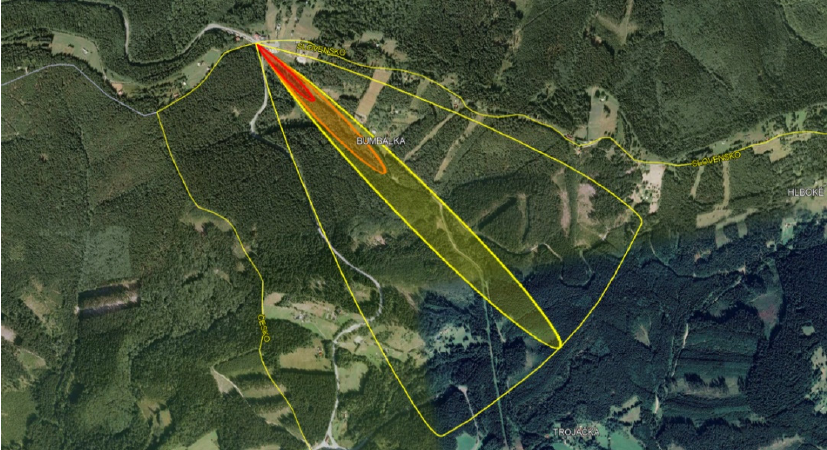
Figure 3. Graphical representation of the dispersion of a dangerous substance at the border crossing Makov-Velké Karlovice-Bíla-Bumbálka